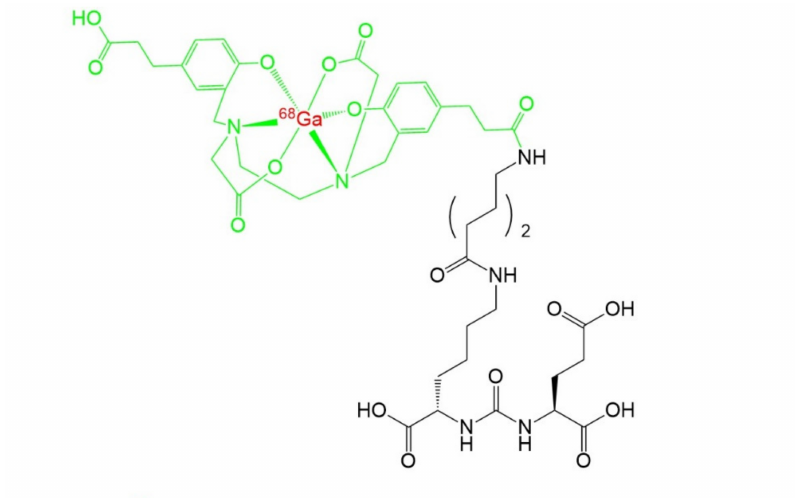
Figure 2. Chemical structure of [ 68